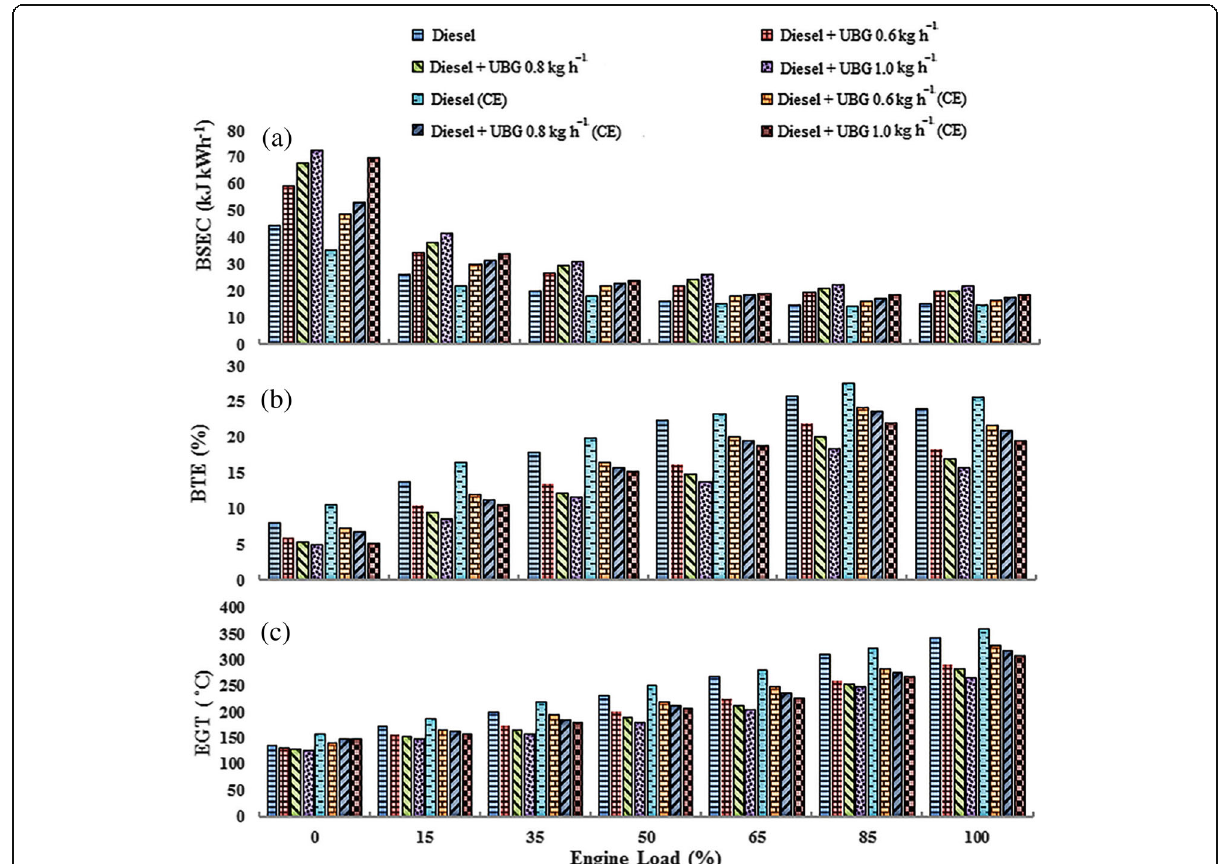
Fig. 2 Change in performance parameters with respect to engine load ( a ) BSEC, ( b ) BTE, ( c )